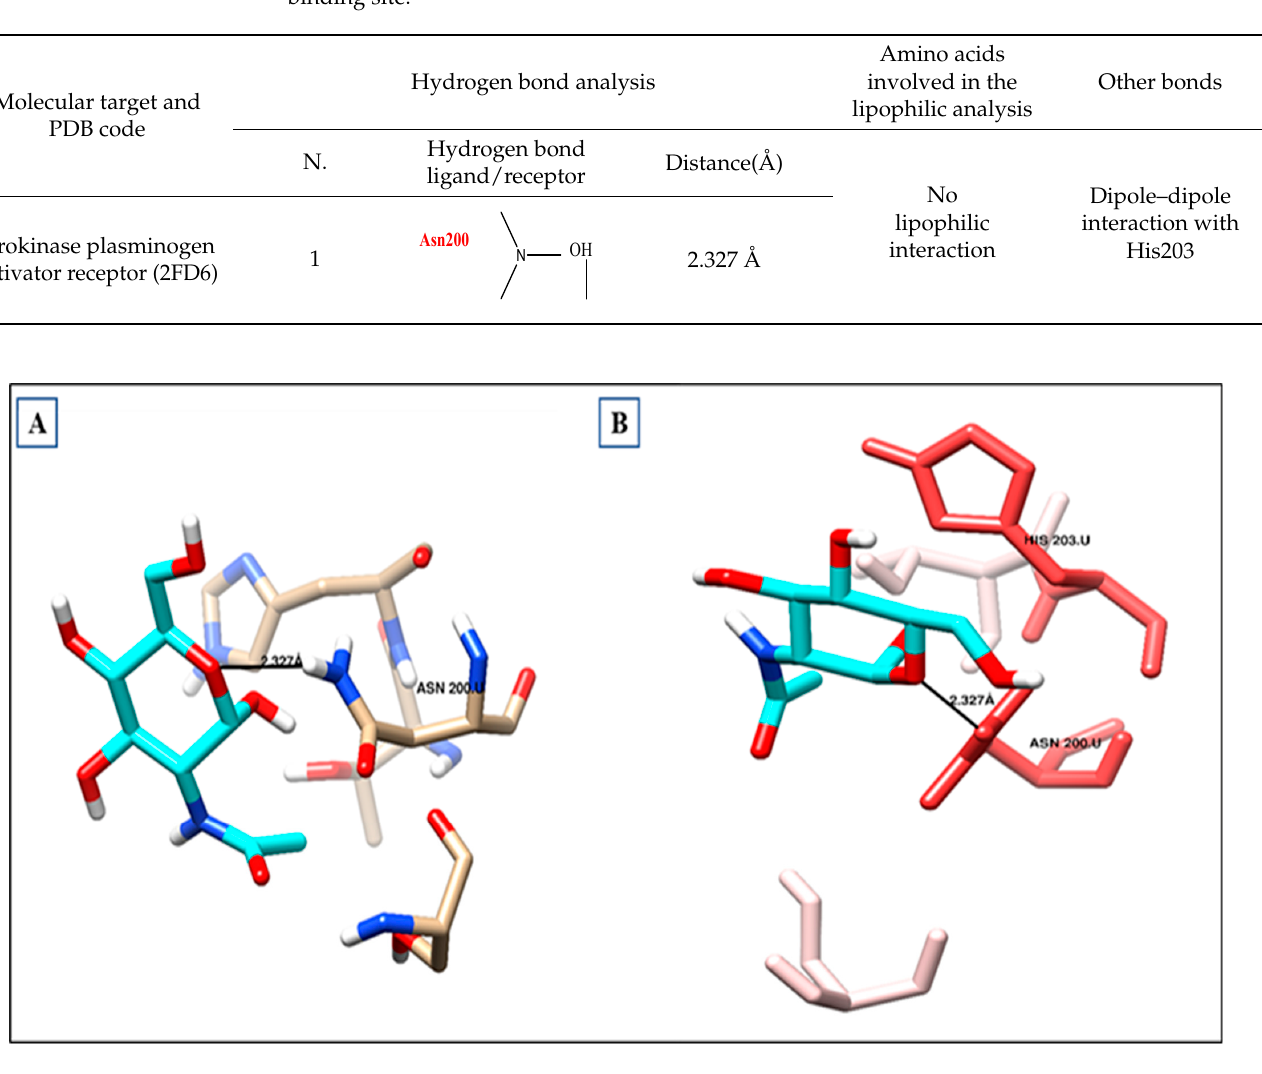
Figure 9. Ligand–receptor interactions: ( A ) binding disposition and ( B ) lipophilic interactions of NDG inside the 2FD6 binding site; red-colored amino acids are the hydrophilic amino acids. The activity of compounds that can act similarly to UPAR was discovered by perform- ing molecular docking to identify the possible ligand–protein interactions. As shown in (Figure 10a,b), compounds 3 and 4 formed two hydrogen bonds with (ASN200 and SER235) and (GLN230 and ASN200), respectively. After superimposing the two tested compounds, we found that they were docked in the same pocket of the co-crystalized ligand, as shown in (Figure 11a,b).